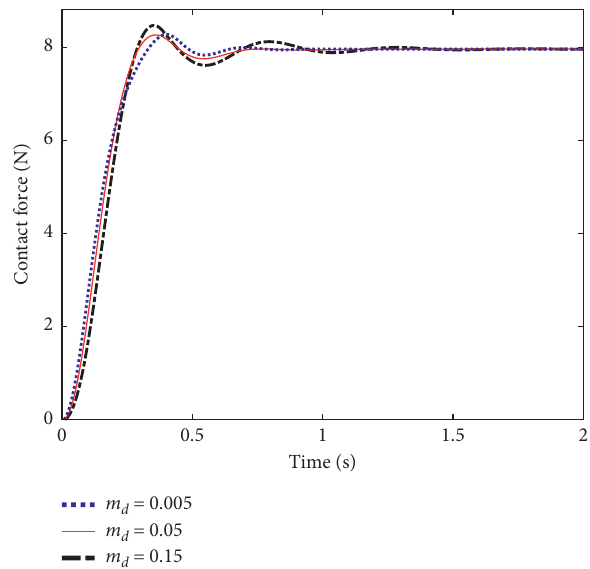
Figure 11: Contact force curves with different inertia